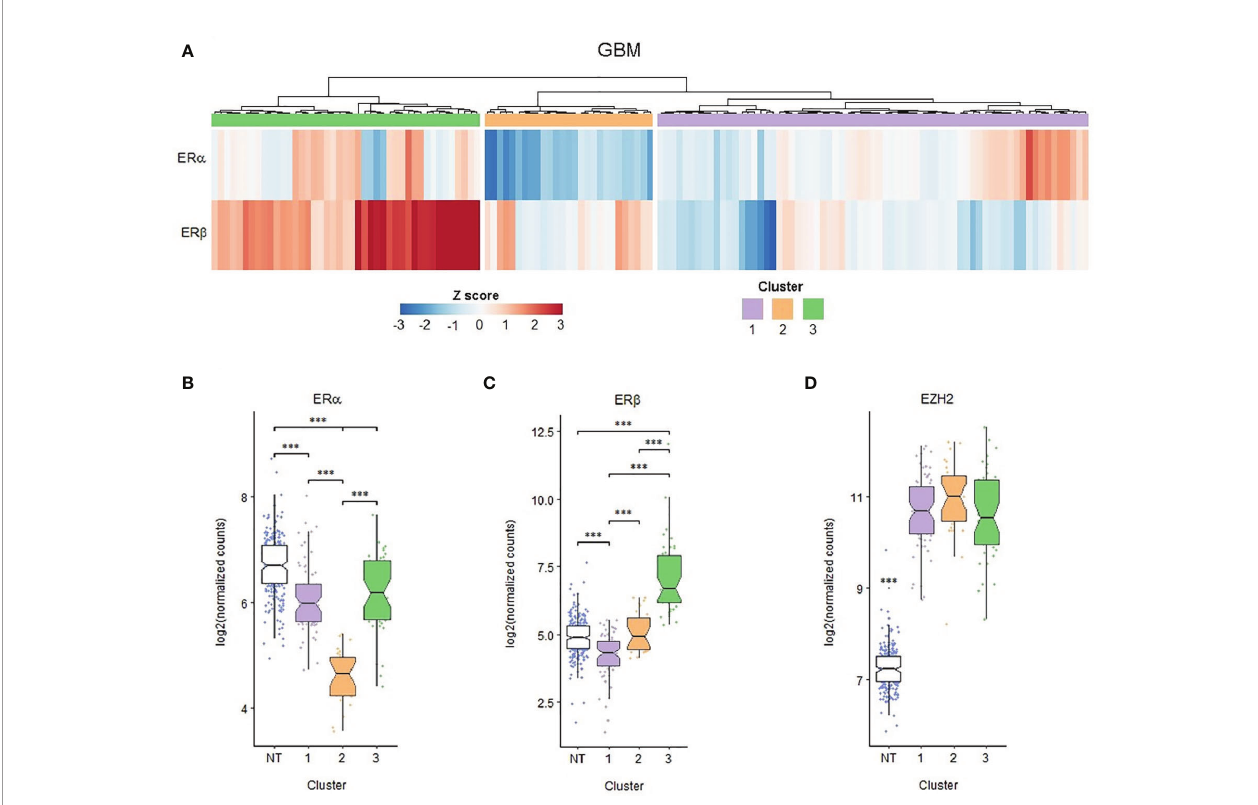
FIGURE 5 | EZH2, ER a and ER b expression clusters in human GBM biopsies. RNA-seq data obtained from TCGA. 139 primary GBM expression pro fi les of 249 healthy brain cortex samples (normal tissue, NT) obtained from the GTEx database were analyzed. (A) Heat map showing the expression of ER a and ER b in each of the primary GBMs studied; based on it, three hierarchical clusters were de fi ned. (B) ER a , (C) ER b and (D) EZH2 expression in the different GBM groups formed and NT. ***p < 0.001. in the different sample